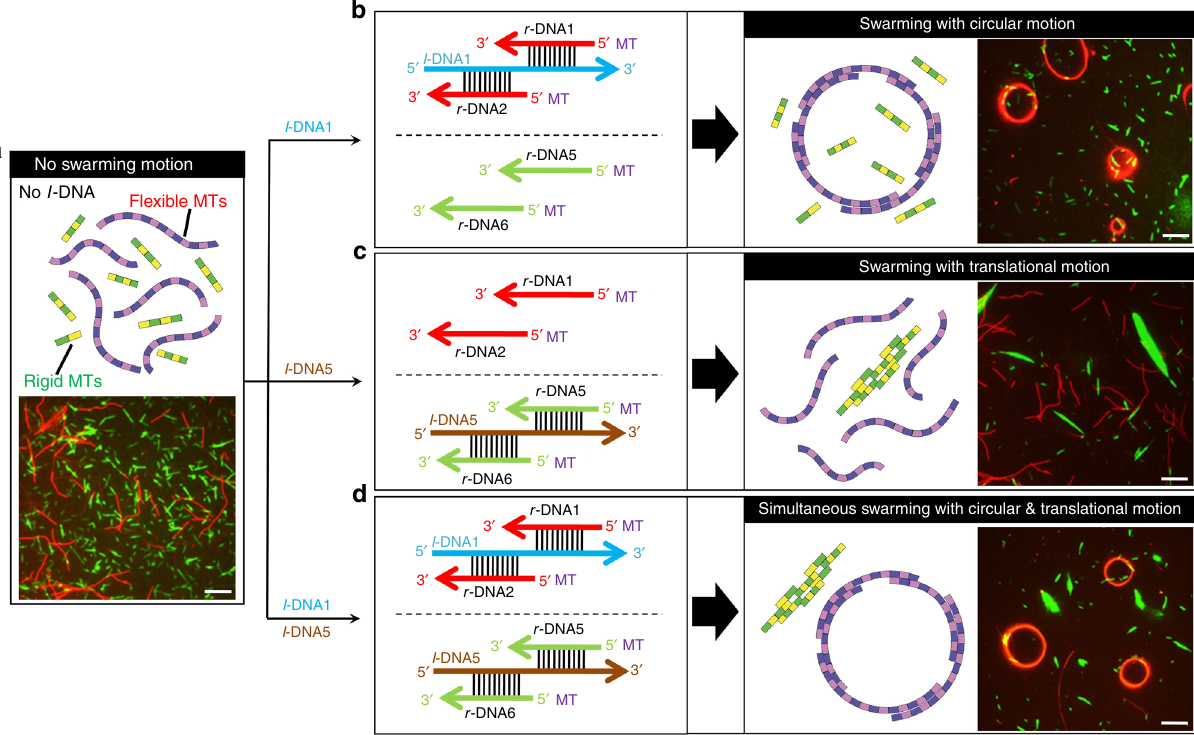
Fig. 4 Orthogonal control of swarming of MTs. a Schematic representation and fl uorescence microscopy image of MTs with different rigidity. The fl exible MTs (red) were conjugated with r -DNA1 and r -DNA2, while the rigid MTs (green) were conjugated with r -DNA5 and r -DNA6. b Upon inputting l -DNA1, the fl exible MTs associated into circular shaped swarms through hybridization of r -DNA1 and r -DNA2 with l -DNA1 and appeared in red. c Green swarms with translational motion associated with rigid MTs were formed through hybridization of r -DNA5 and r -DNA6 with l -DNA5. d Swarms with translational and circular motions were simultaneously formed in response to the introduction of both input DNA signals. The concentration of red and green MTs was 0.6 µ M each, and the conjugation ratio of each r -DNA to MTs was ~100%. The concentration of kinesin was 0.3 µ M and that of each l -DNA was 0.6 µ M. Scale bars: 20 µ